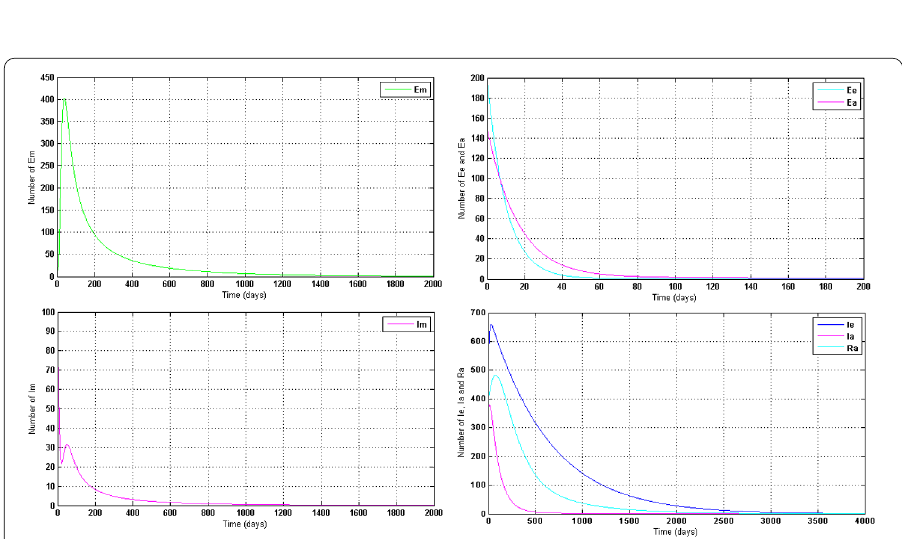
Figure 5 Evolution of the different clinics classes of the human population for p = 0.25, (cid:9) h = 10, c me = 0.021, c ma = 0.012, c em = 0.11, c am = 0.08, ˜ c me = 0.008, ν e = 0.10, ν a = 0.06, ν m = 0.083, α a = 0.01, α e = 0.001, γ e = 0.000018, γ a = 0.00003, β a = 0.0055, f h = 0.00063, f m = 0.1, n a = 0.25, b = 10.7, S E = 0.4, d E = 0.36, s L = 0.5, d L = 0.34, s P = 0.3, d P = 0.17 and f m = 0.15. These values lead to r = 14.26 and R 0 = 0.81